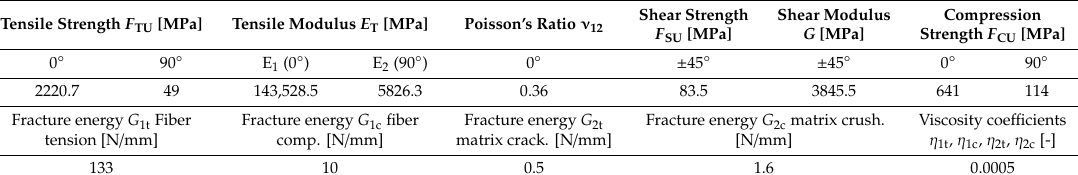
Table 1. Mechanical and strength properties of the composite